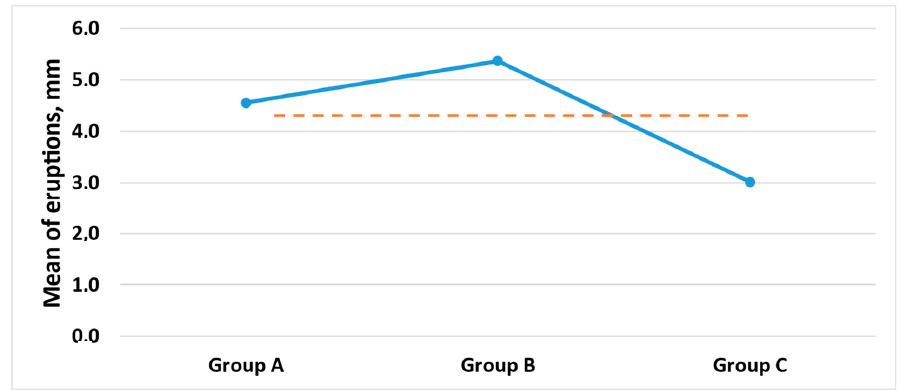
Figure 13. Mean of eruption in mm in the interval T0 ‐